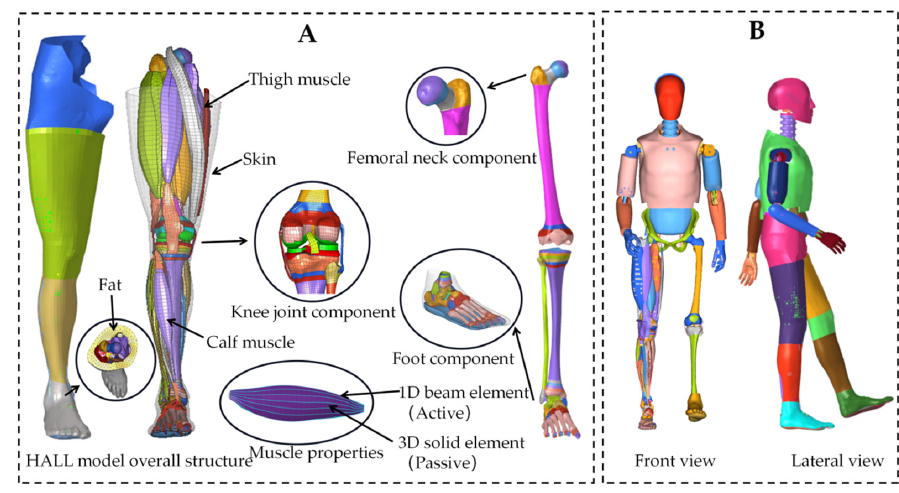
Figure 1. HALL model ( A ) and the Chinese 50th percentile pedestrian model ( B